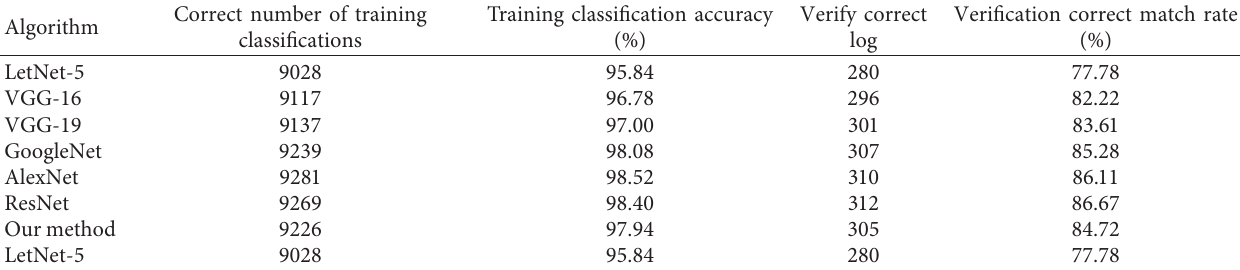
Table 7: Comparison of facial FE performance of different models.